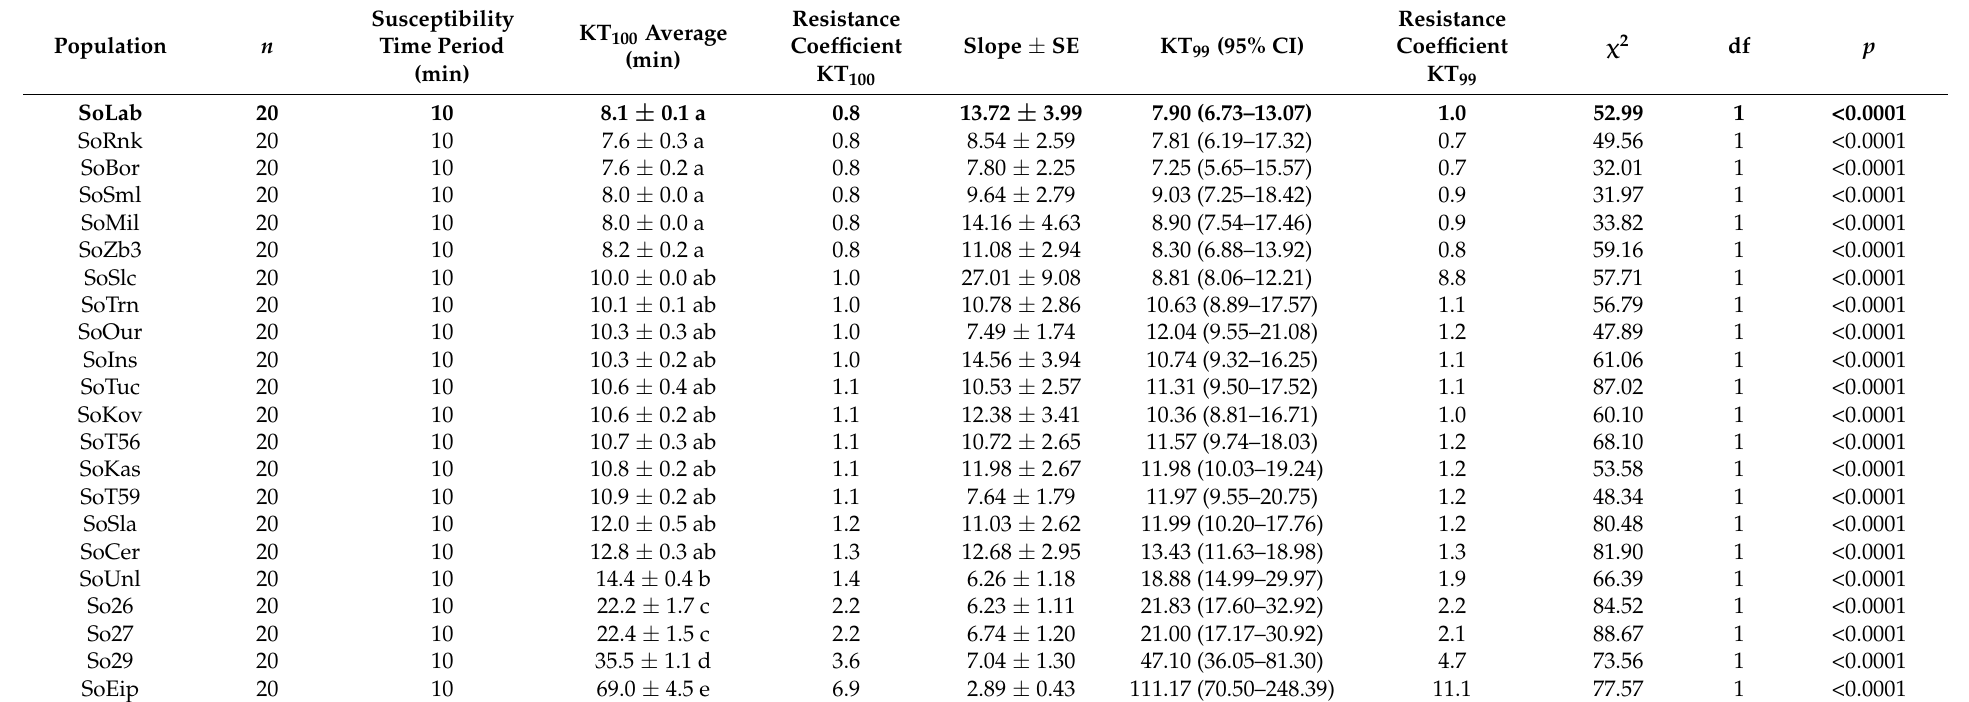
Table 1. Susceptibility or tolerance of 22 populations of Sitophilus oryzae to phosphine based on the knockdown rapid test (PTT–Degesch, Gemany) from the Czech grain stores and the statistical comparison among the tested populations (21 field populations and 1 reference laboratory SoLab population). (Different letters (a–e) indicate statistically significant differences; n = numbers; p = p